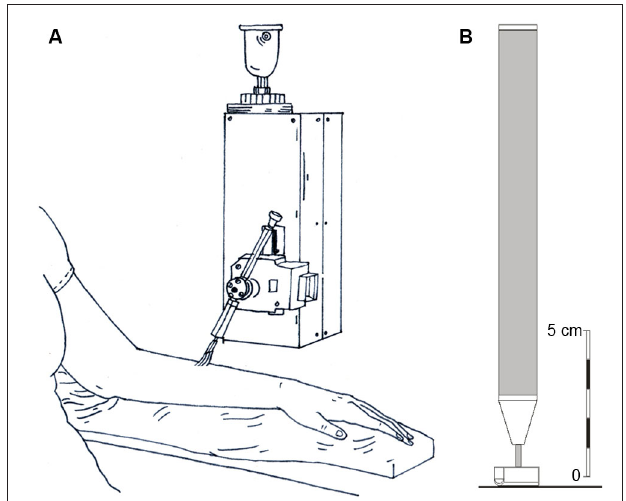
FIGURE 1 | Diagrammatic representations of the stroking stimuli and the tactile direction discrimination probe. (A) The rotary tactile stimulator, where a soft brush was stroked at precise velocities across each skin site and psychophysical ratings of pleasantness were gained. (B) The probe used for the tactile direction discrimination task, which was moved across the skin over specified